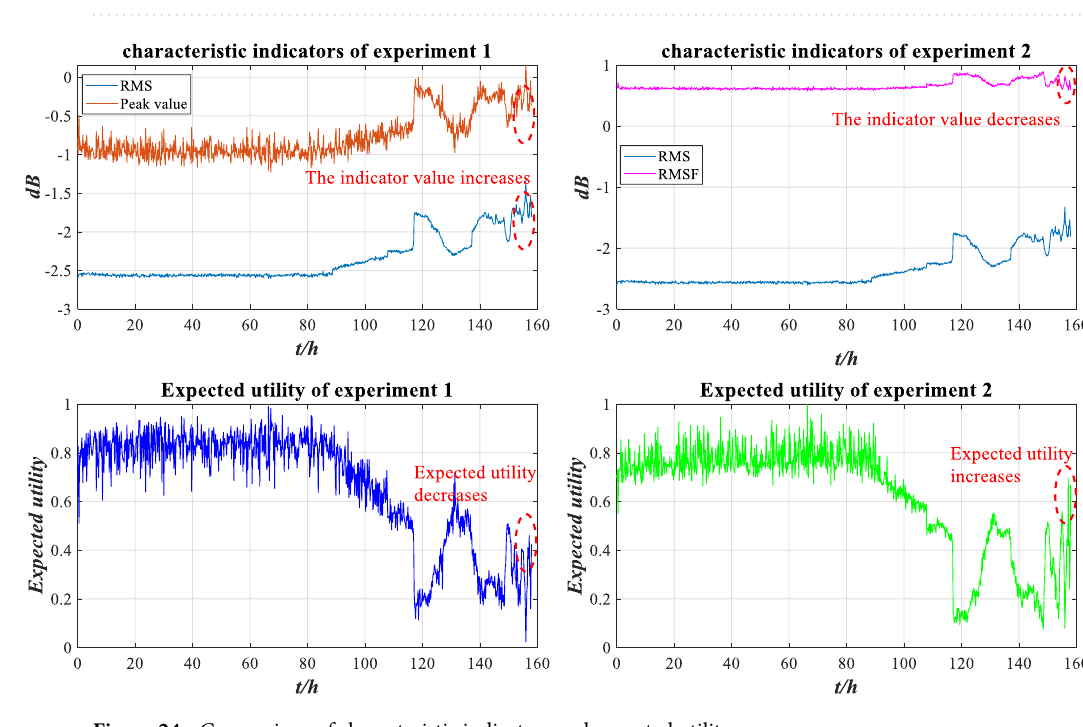
Figure 24. Comparison of characteristic indicators and expected